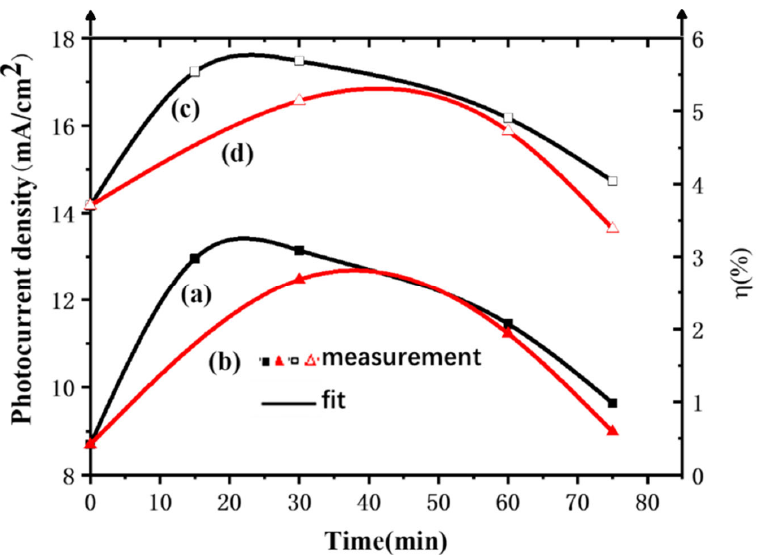
Figure 14. Variations in short-circuit current densities versus immersion time of DSC after surface modification with different concentrations of TiCl 4 aqueous solution: (a) 40 mM; (b) 50 mM. Variations in energy conversion efficiencies versus immersion time of DSC after surface modification with different concentrations of TiCl 4 aqueous solution: (c) 40 mM; (d) 50 mM.